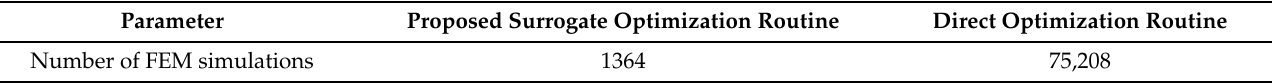
Table 20. Comparison of the number of FEM simulations in proposed surrogate optimization routine and direct optimiza- tion routine.